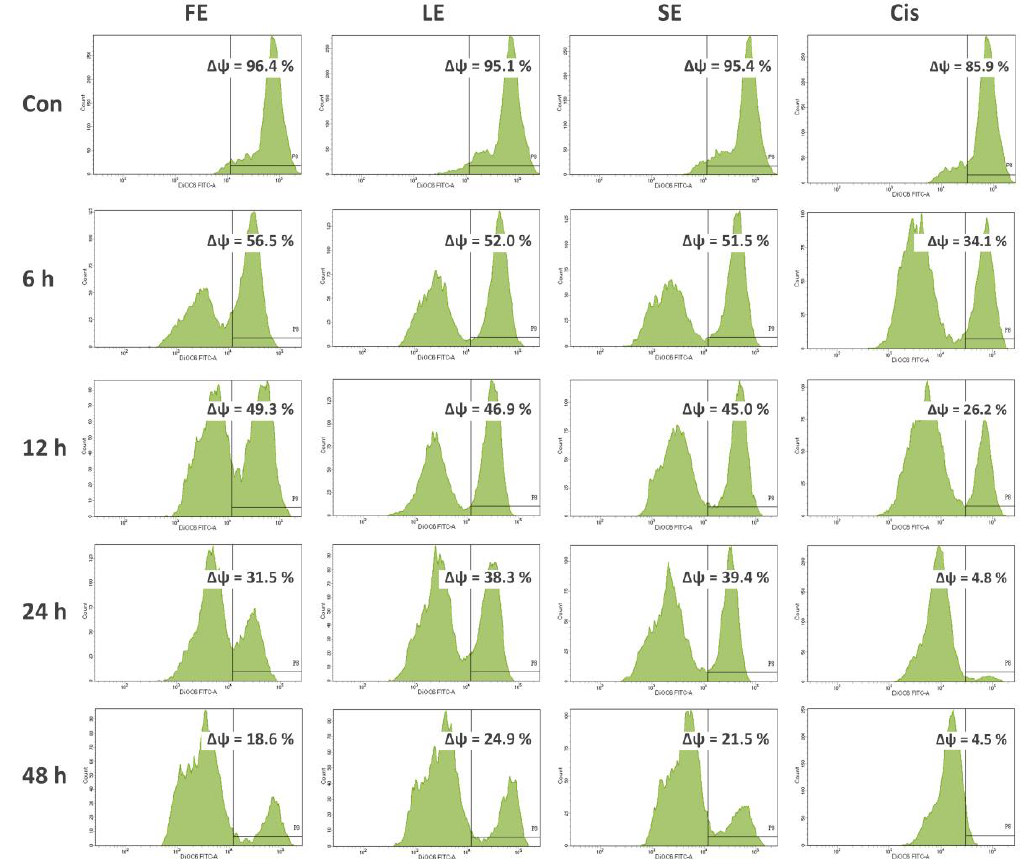
Figure 2. The changes of the mitochondrial membrane potential (ΔΨ) level in Caco-2 cells treated with broccoli extracts (0.20 mg/mL) and cisplatin (0.02 mg/mL) for various time points and analyzed using flow cytometry after staining with DiOC 6 (3,3′-dihexyloxacarbocyanine iodide).